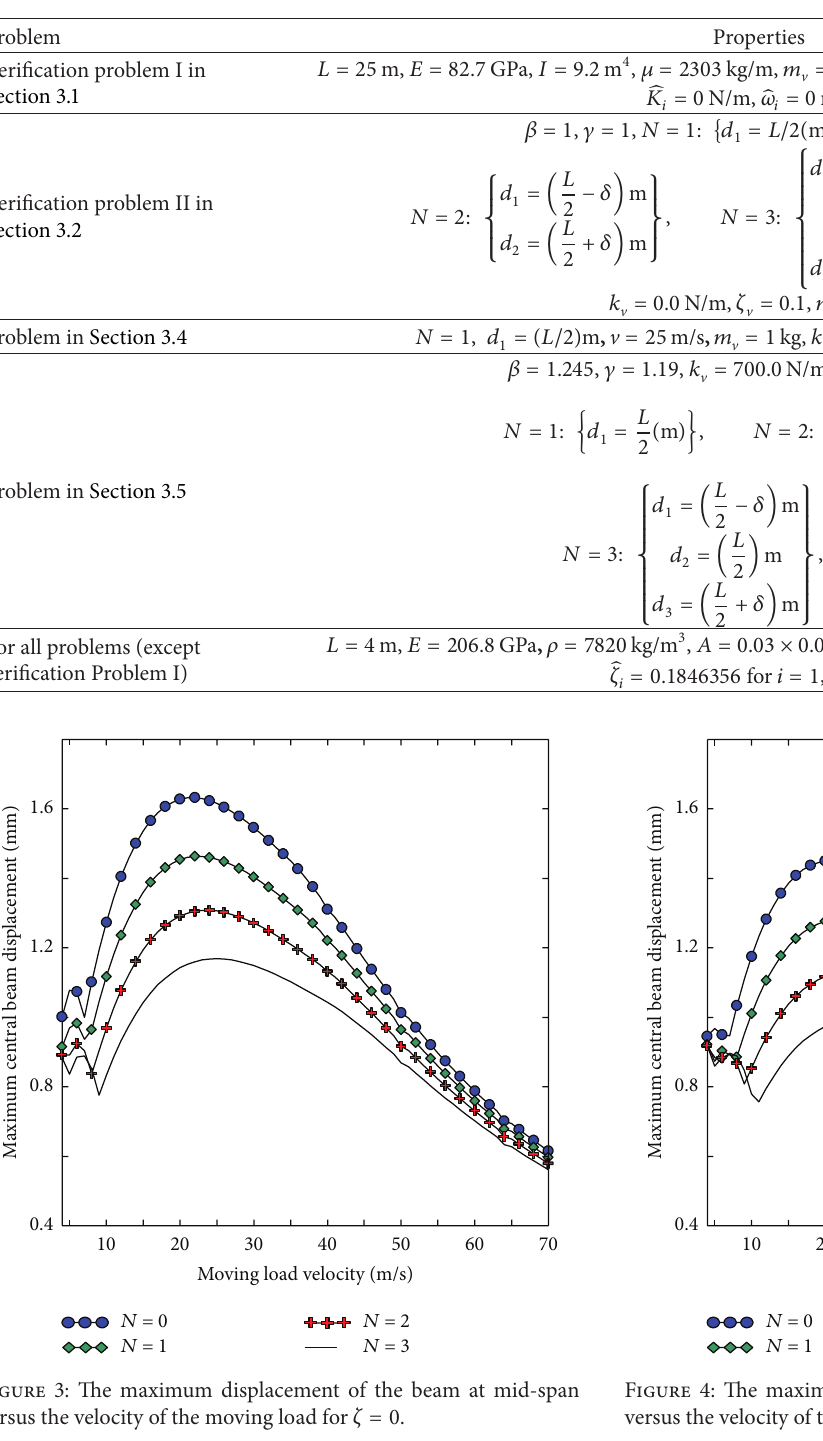
Table 1: Material and geometrical properties of beam, vehicle, and absorbers.